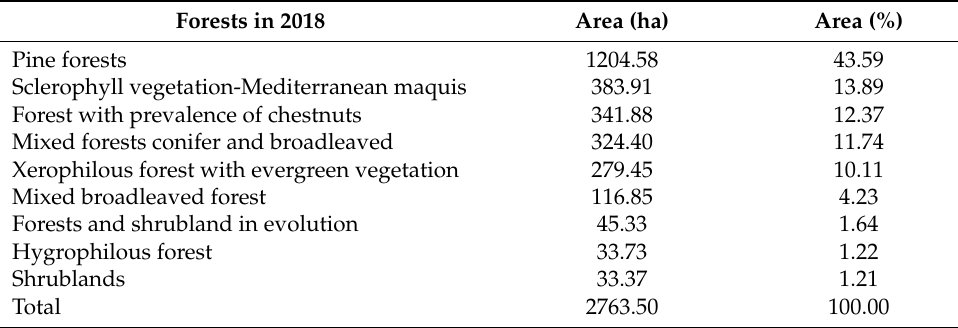
Table 3. Different types of forest cover for the area of the 5TNP in